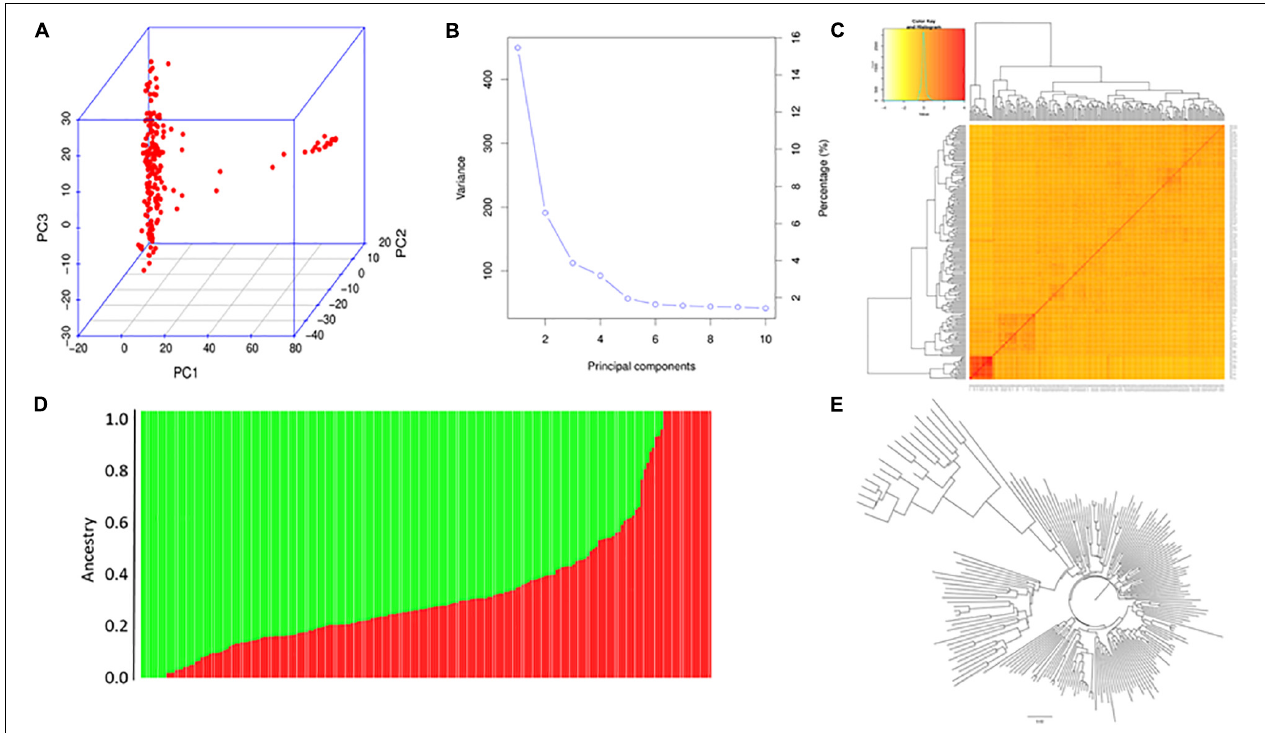
FIGURE 4 | Population analysis for the XI-1A panel. (A) Principal component analysis (PCA) plots. (B) Total variation explained by the principal components (PCs). (C) Kinship relatedness. (D) Two subgroups inferred by structure analysis. (E) Neighbor-joining (NJ)